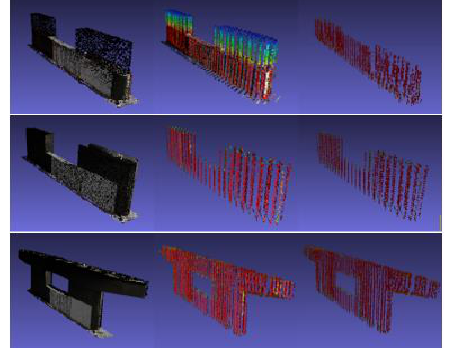
Figure 8. The registration results, Hausdorff distance sampling heat map and simpling results for 3 cases of Pier 1 (Left to right, top to bottom